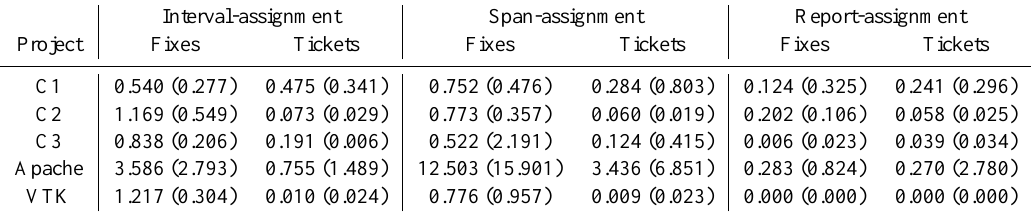
Fig. 4. Defect density of projects by defect assignment method. Previously published defect densities from Table 1 are shown on the right.